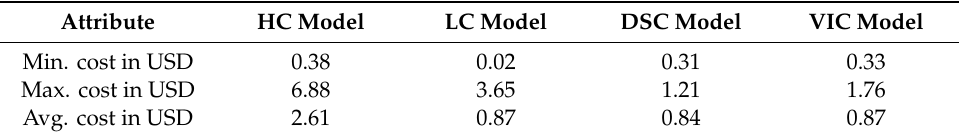
Table 1. Summary of the switch cost